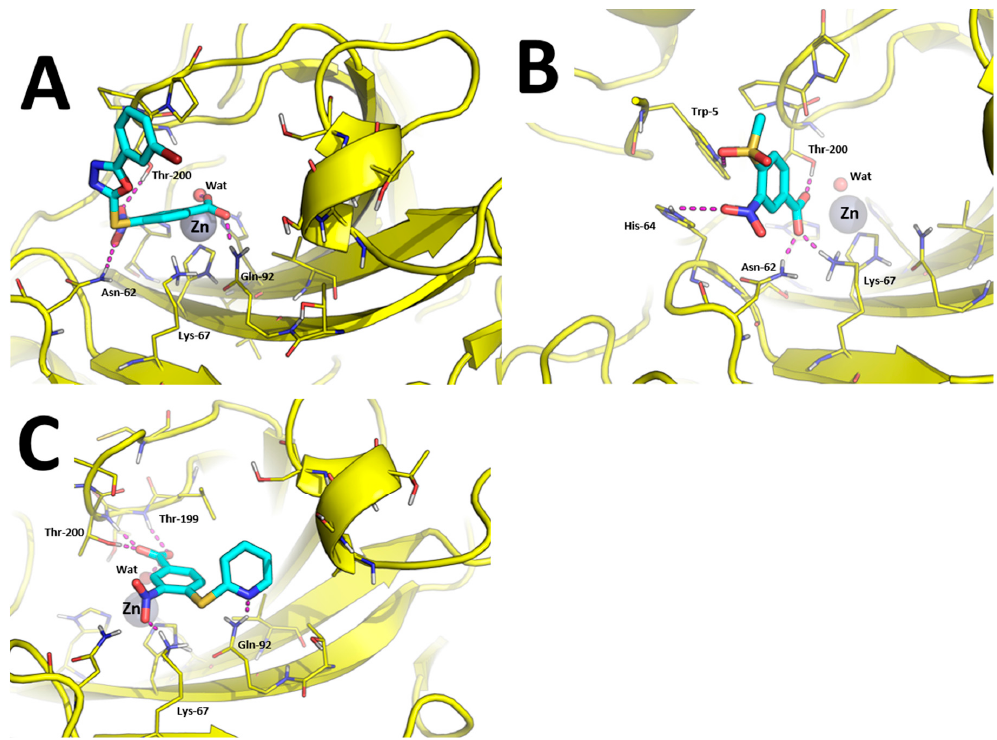
Figure 4. Binding mode of most promising hCA XII inhibitors predicted by molecular docking and energy minimization. ( A ) Compound 1 ; ( B ) compound 7 ; and ( C ) compound 10 . Small molecules are showed as cyan sticks, the 3D structure of hCA XII is showed as yellow cartoon. hCA XII residues involved in binding to compounds are showed as yellow lines and are labeled. H-bonds are highlighted as magenta dashed lines.